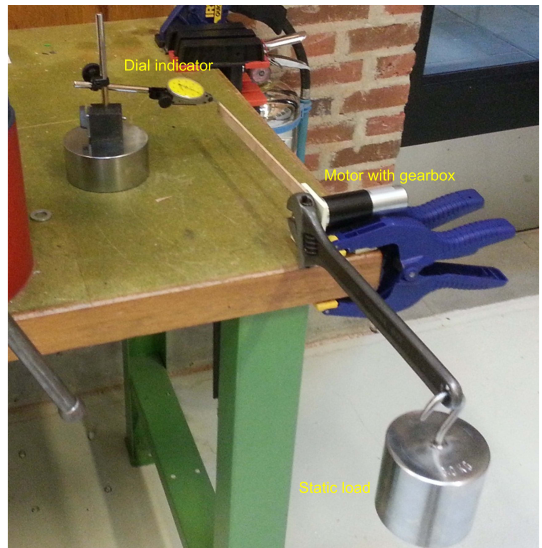
Figure 6: Experimental setup of the actuation stiffness